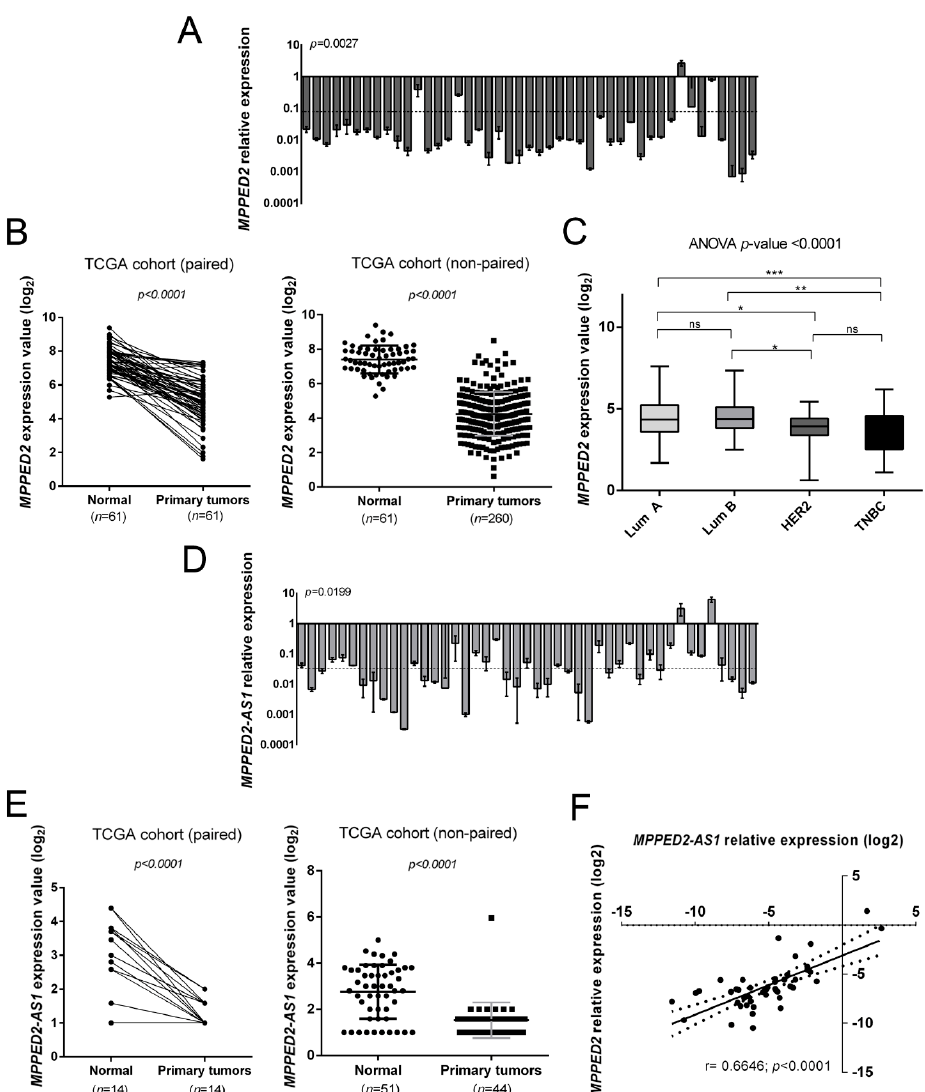
Figure 1. Expression of MPPED2 and MPPED2-AS1 in human breast carcinoma tissues. ( A ) MPPED2 expression levels were evaluated by quantitative real-time polymerase chain reaction (qRT-PCR) in 45 breast carcinoma tissues. The dashed line represents the average relative expression value of the analyzed samples ( p = 0.0027). Data are reported as 2 −ΔΔ Ct values ± standard deviation (SD), compared to the mean of breast normal tissues, set equal to 1. ( B ) MPPED2 expression levels were evaluated in a dataset available in The Cancer Genome Atlas (TCGA). Paired (left panel) and non-paired (right panel) breast cancer samples were analyzed. t -test: ****, p < 0.0001 (primary tumors vs. normal tissues in both paired and non-paired samples). ( C ) MPPED2 expression levels were evaluated in the molecular subtypes of breast carcinoma tissues (Lum A, Lum B, HER2 and TNBC) in the TCGA dataset. Box and whiskers: Min to max. One-way analysis of variance (ANOVA) test: ****, p < 0.0001. ( D ) MPPED2-AS1 levels were evaluated in 45 breast carcinoma tissues by qRT-PCR. The dashed line represents the average relative expression value of the analyzed samples ( p = 0.0199). Data are reported as 2 −ΔΔ Ct values ± SD, compared to the mean of breast normal tissues, set equal to 1. ( E ) MPPED2-AS1 expression levels were evaluated in the TCGA dataset. Paired (left panel) and non-paired (right panel) breast cancer samples were evaluated and only samples in which MPPED2-AS1 was detectable were considered for the analysis. t -test: ****, p < 0.0001 (primary tumors vs. normal tissues in both paired and non-paired samples). ( F ) Correlation scatter plot (Spearman’s Rank) between qRT-PCR levels of MPPED2 and MPPED2-AS1 analyzed in 45 breast carcinoma samples (r = 0.6646; ****, p <